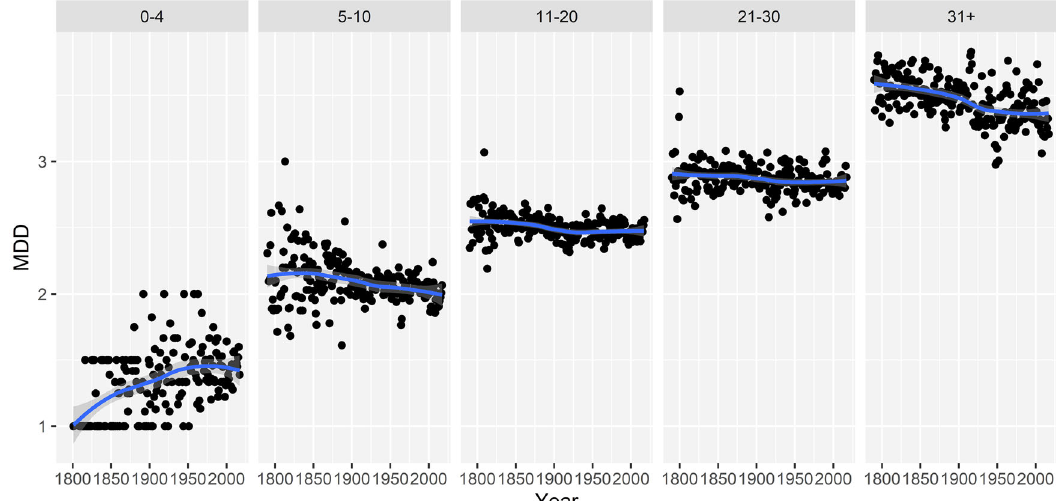
Fig. 2 Time series plots of MDDs at sentential level. The fi ve columns show the trend of MDDs of sentences with different lengths. The blue lines represent fi tting